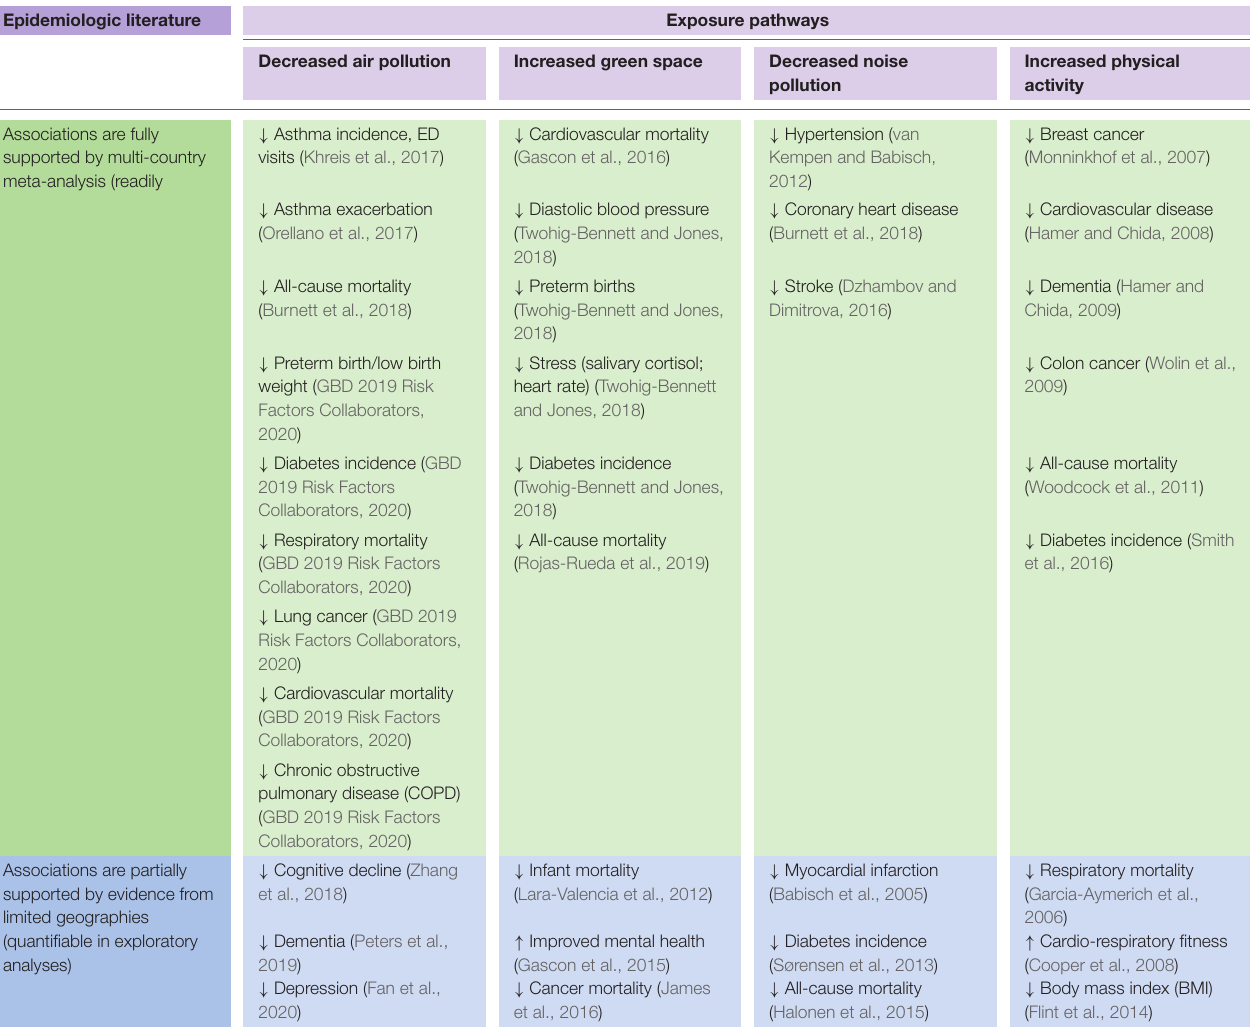
TABLE 1 | Summary of the evidence for health outcomes associated with the four pathways reviewed in this paper, the direction of the association, and references for example meta-analyses. Epidemiologic literature Exposure pathways Decreased air pollution Increased green space Decreased noise